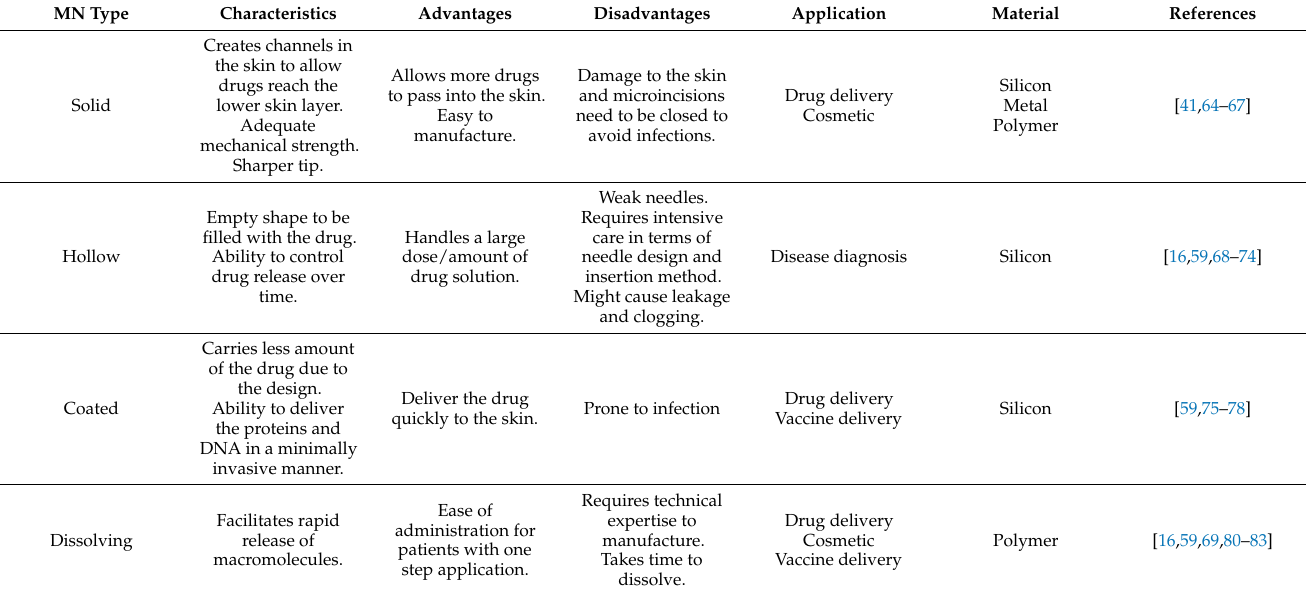
Figure 8. Fabrication of the coated polymer MNs: ( A ) A schematic diagram of the process to fabricate the coated polymer MNs. The coated polymer MNs were fabricated by (I) covering up the surface of the polydimethylsiloxane (PDMS) cavities with heated and melted PLA, (II) filling the mold cavities with melted PLA, (III) exerting pressure on the melted PLA and cooling it down to room temperature, (IV) dipping the coating solution using PLA MNs, and (V) drying the coated polymer MNs. Image (A1) is an image of the 650 µ m long PLA MNs. Image (A2) is an image of the 650 µ m long MNs coated with formulation III. Image ( B ) is a schematic diagram of the adjustable apparatus that can be lifted and lowered. Image (B1) shows the portable holder with the PLA MNs descending into the reservoir. Image (B2) shows the PLA MNs dipped in the coating solution, and image (B3) shows the portable holder rising from the reservoir [79]. Reprinted from Journal of Controlled Release, Vol. 265, Yang Chen et al., Fabrication of coated polymer MNs for transdermal drug delivery, Pages 14–21, Copyright (2017), with permission from Elsevier. Table 1. Overview: Microneedle